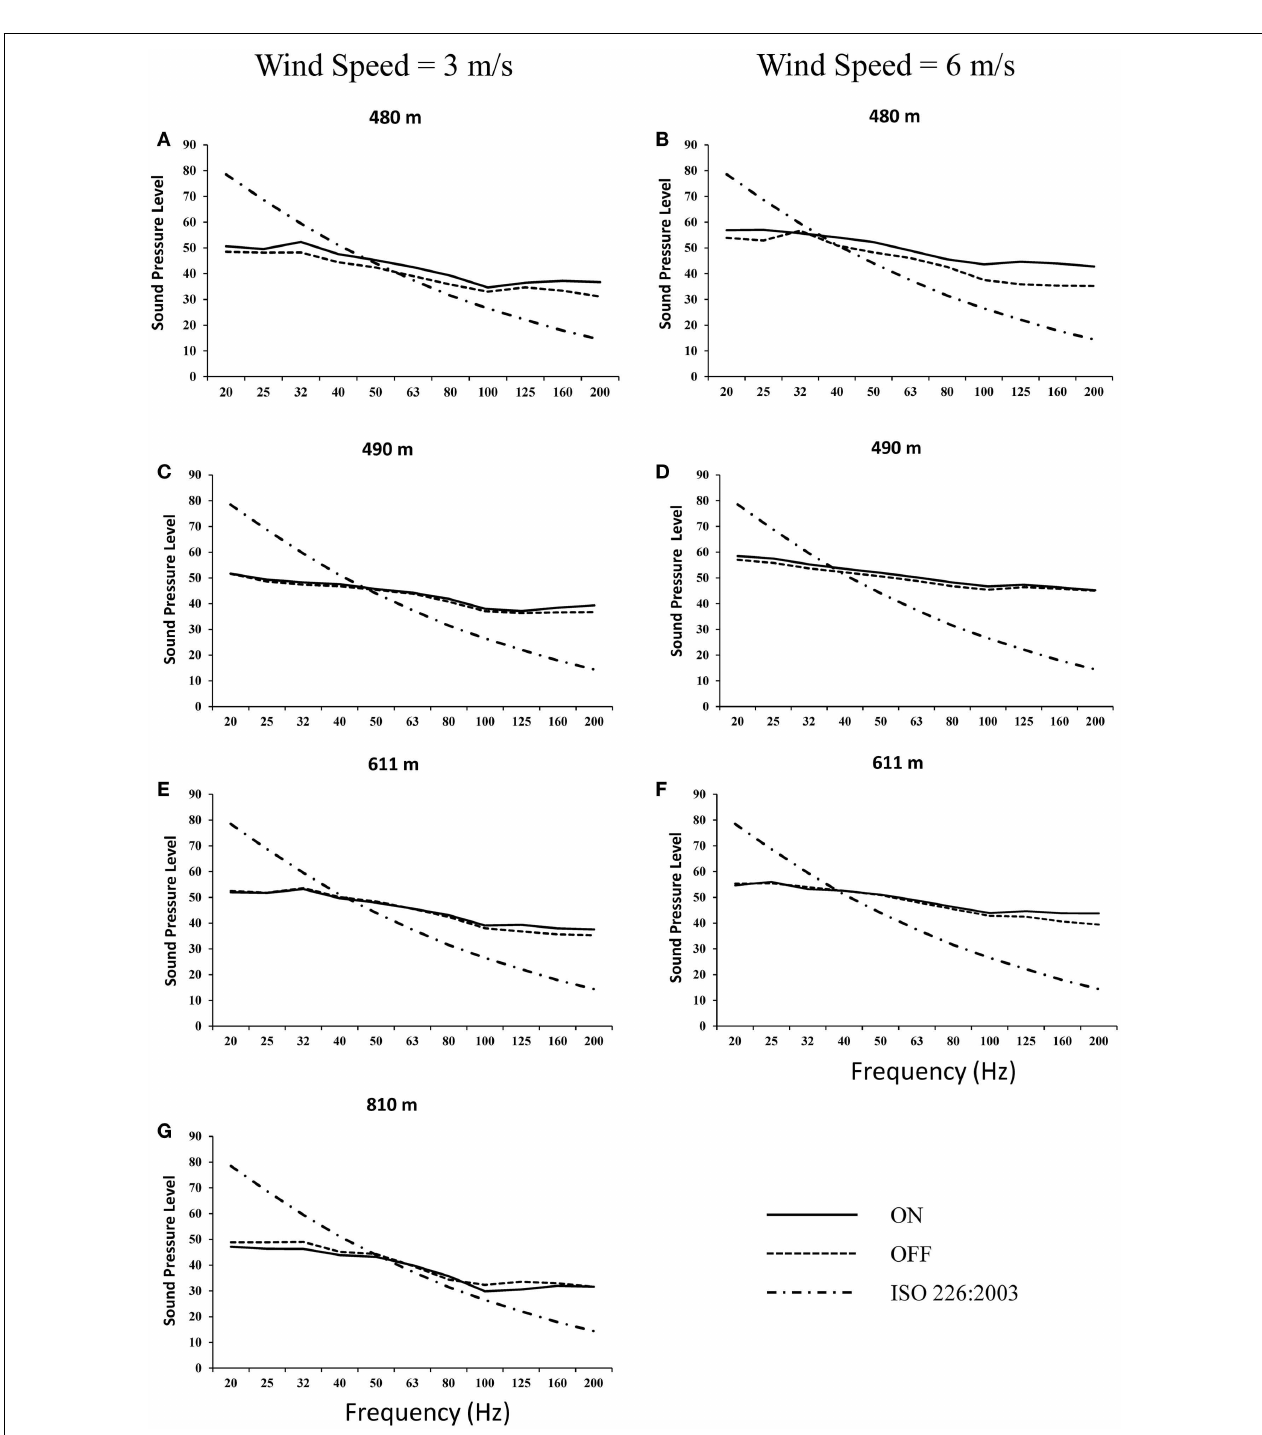
FIGURE 1 | Outdoor low-frequency noise measurements at 480m (A,B), 490m (C,D), 611m (E,F), and 810m (G) from 1.5MW wind turbines with wind speeds of 3m/s (A,C,E,G) and 6m/s (B,D,F) with turbines on and off. Hearing threshold (ISO 226:2003) is also provided .